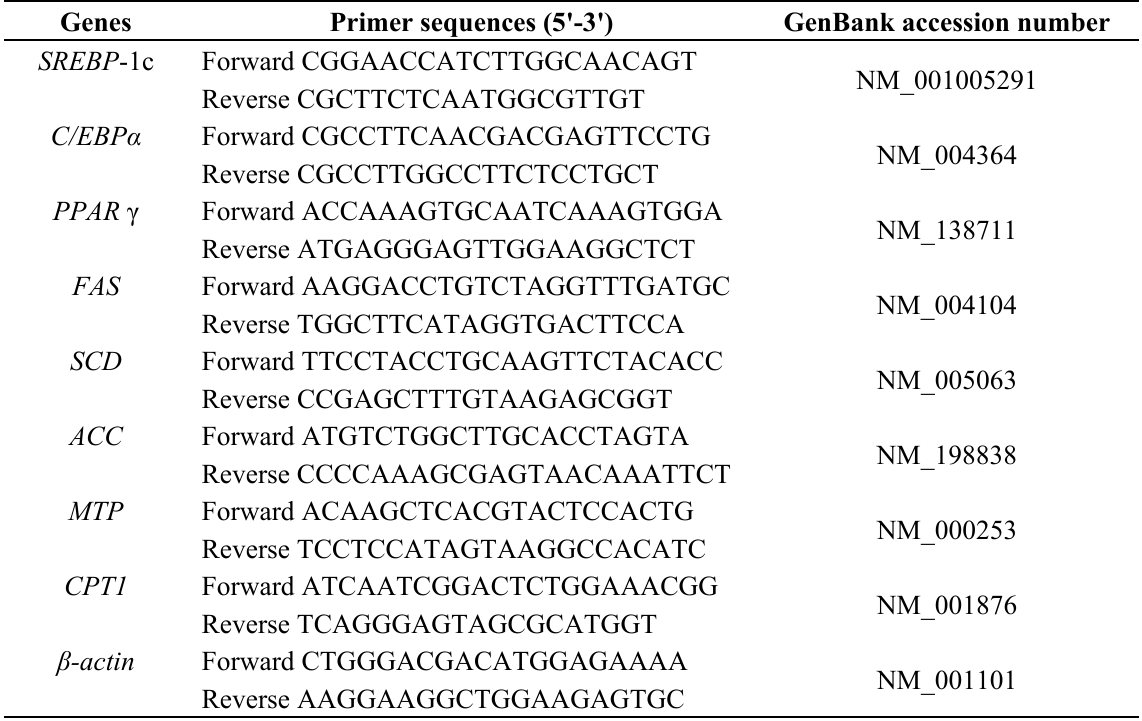
Table 1. Primer sequences used for real-time RT (Reverse